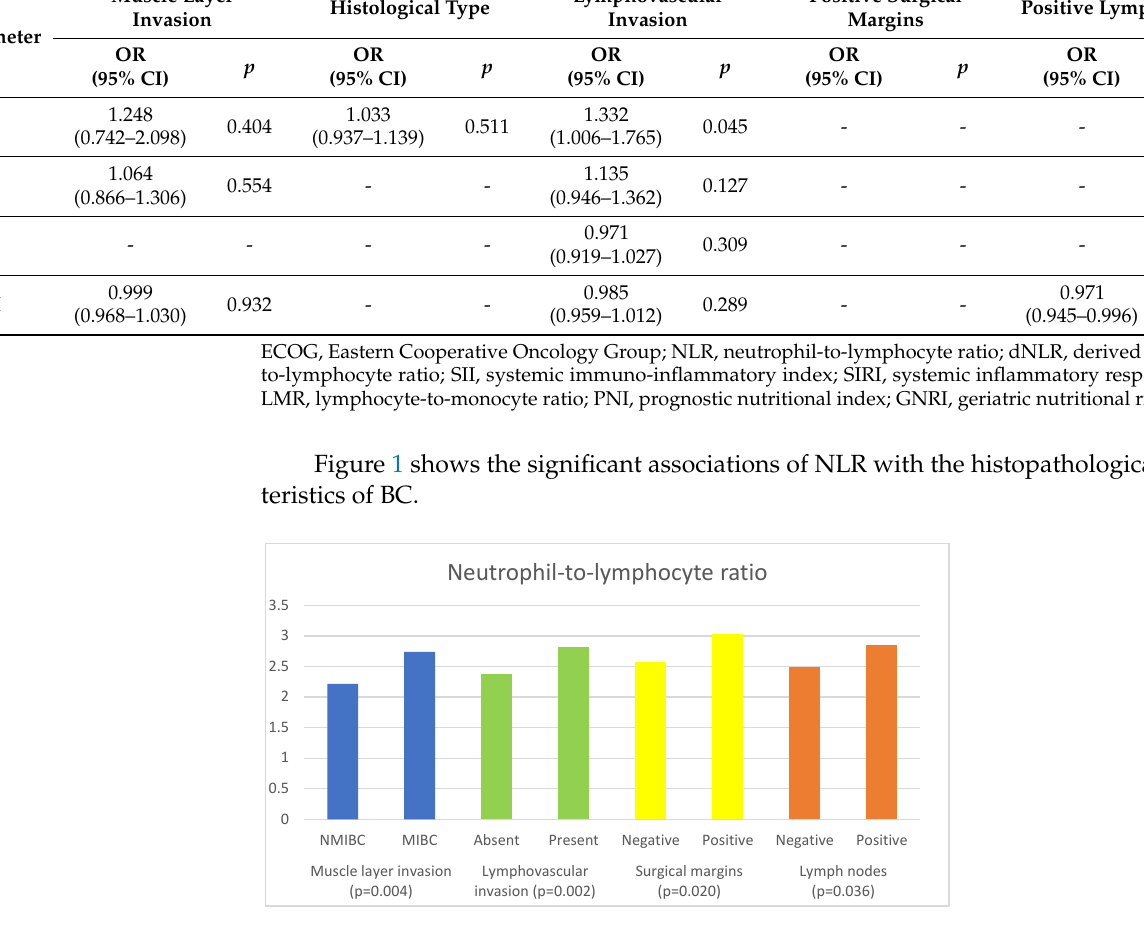
Figure 1. Significant associations of neutrophil-to-lymphocyte ratio with histopathological charac- teristics of bladder cancer. The significant associations of dNLR with the histopathological characteristics are shown graphically in Figure 2.